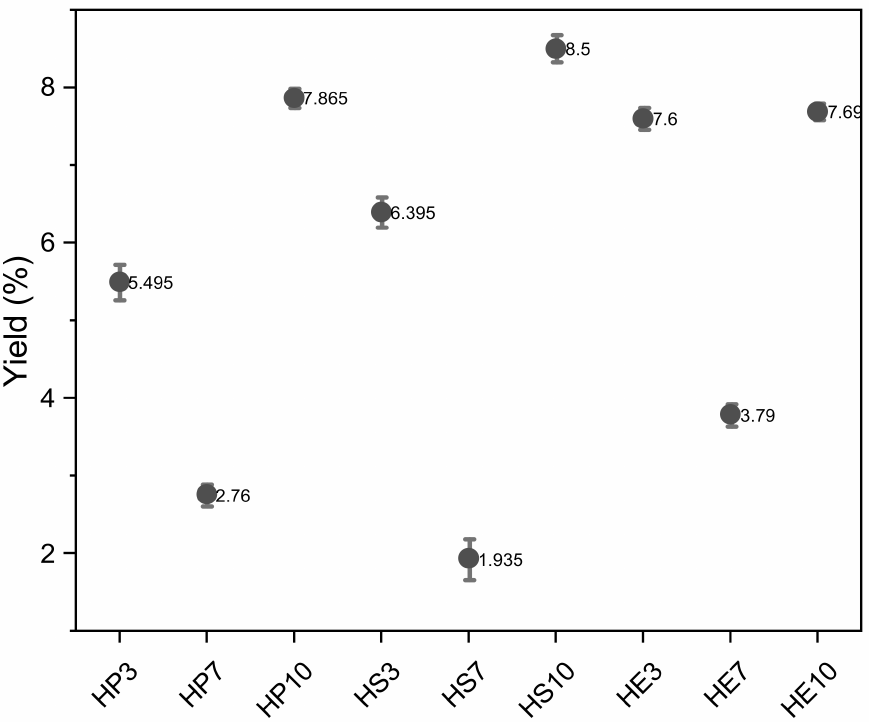
Figure 1. Percentage of hydrocolloid extraction from the seed, peel, and pulp of mango ( Mangifera in- dica ) var. hilaza. HP (pulp hydrocolloid), HS (seed hydrocolloid), and HE (peel